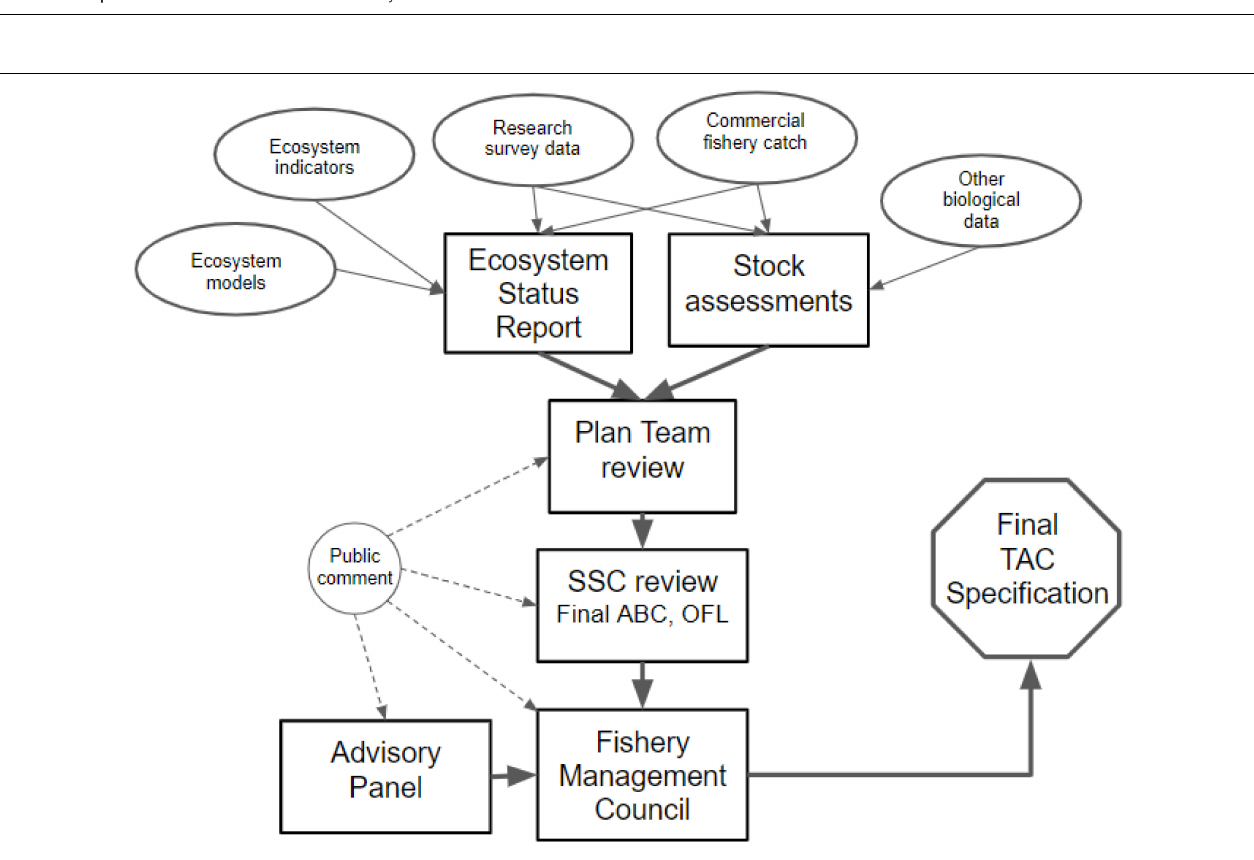
FIGURE 4 | Summary of annual groundfish federal management cycle in Alaska, from assessments through council review and final catch quotas. ABC, allowable biological catch; OFL, overfished level; TAC, total allowable catch (i.e., catch quota).